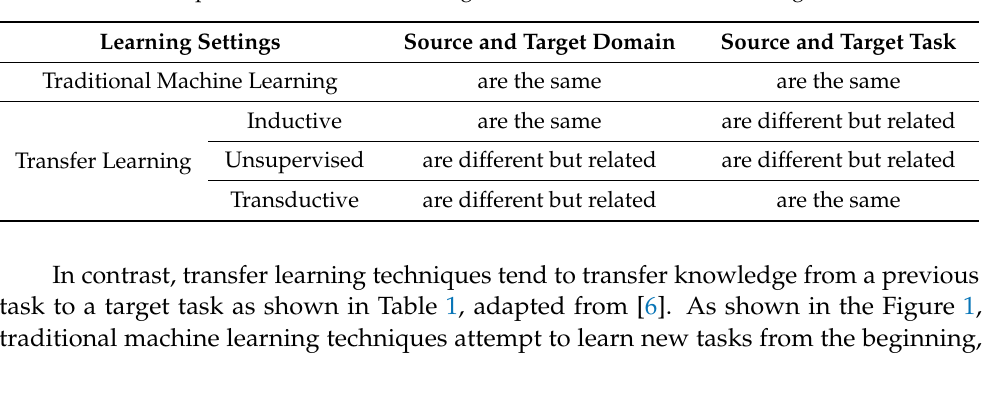
Table 1. Relationship between Transfer learning and traditional machine learning.